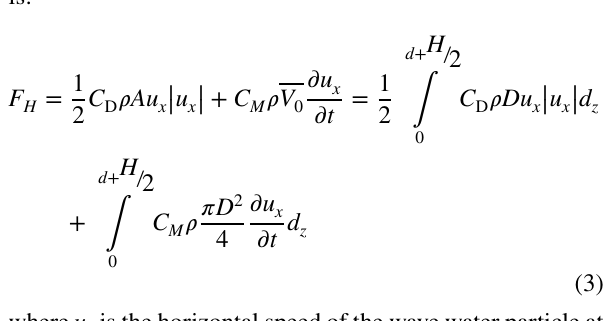
Fig. 3 Wave parameters under different main